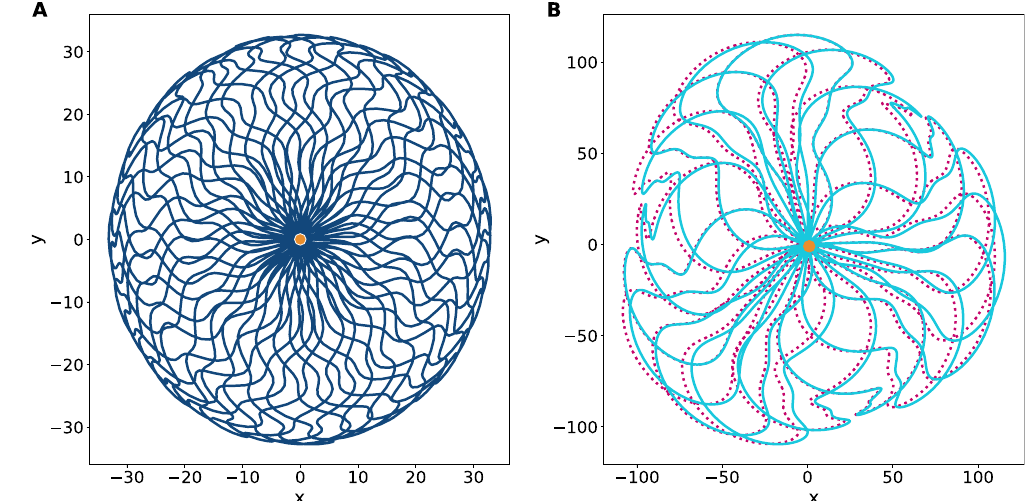
Figure 5. ( A ) Evolution loops performed via a polyharmonic field amplitude β( t ) characterised with 2, c 5 , (see dotted pulse in Fig. 3). The charged particle has the initial conditions the parameters b = = − ( x , y ) ( 0, 0 ) and ( p x , p y ) ( 10, 5 ) . The operation completes the loop after a period T = = evolution loop in terms of the polyharmonic field β( t ) with parameters b 1 ) , ( p , p 30, 30 ) subject to an external force of magnitude F ( x , y ) ( 1, x y ) = ( − = − solid (dotted) line, the unperturbed (perturbed) loop, closing after a period T a drifting effect in the opposite direction of the externally applied force. The dot at the centre of both figures represents the initial and final